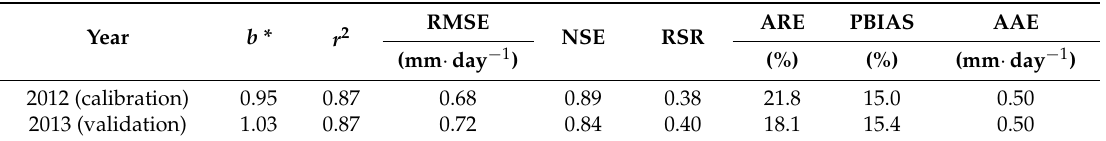
Table 5. Indicators of goodness of fit relative to the model tests of the crop evapotranspiration for the cotton under mulched drip irrigation.